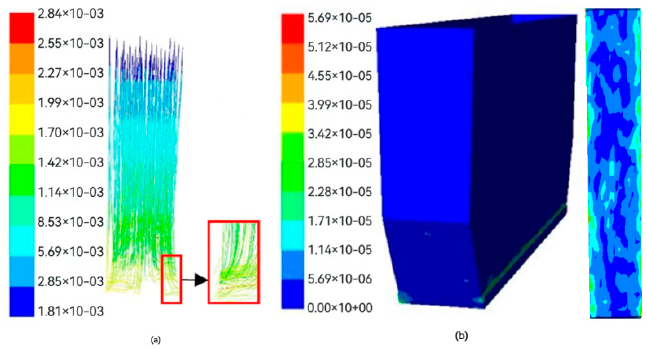
Figure 6. Particle trajectory diagram ( a ) and the erosion rate contour of screen ( b ).